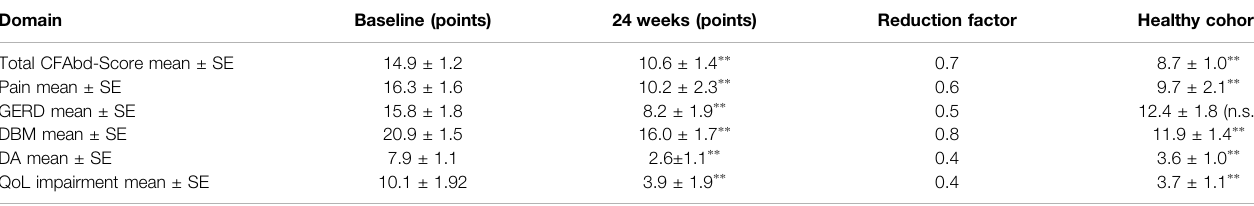
TABLE 2 | Estimated marginal means of the total CFAbd-Score and its fi ve domains at 24 weeks for the whole CF cohort ( n = 107), as calculated according to the validated algorithm elaborated according to FDA guidelines for development of a PROM.